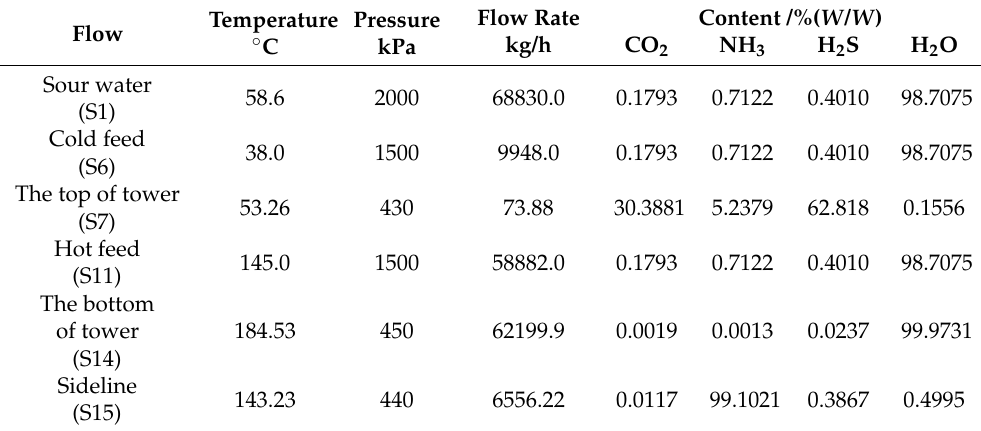
Table 1. Calculation results of main logistics parameters of sour water stripper.